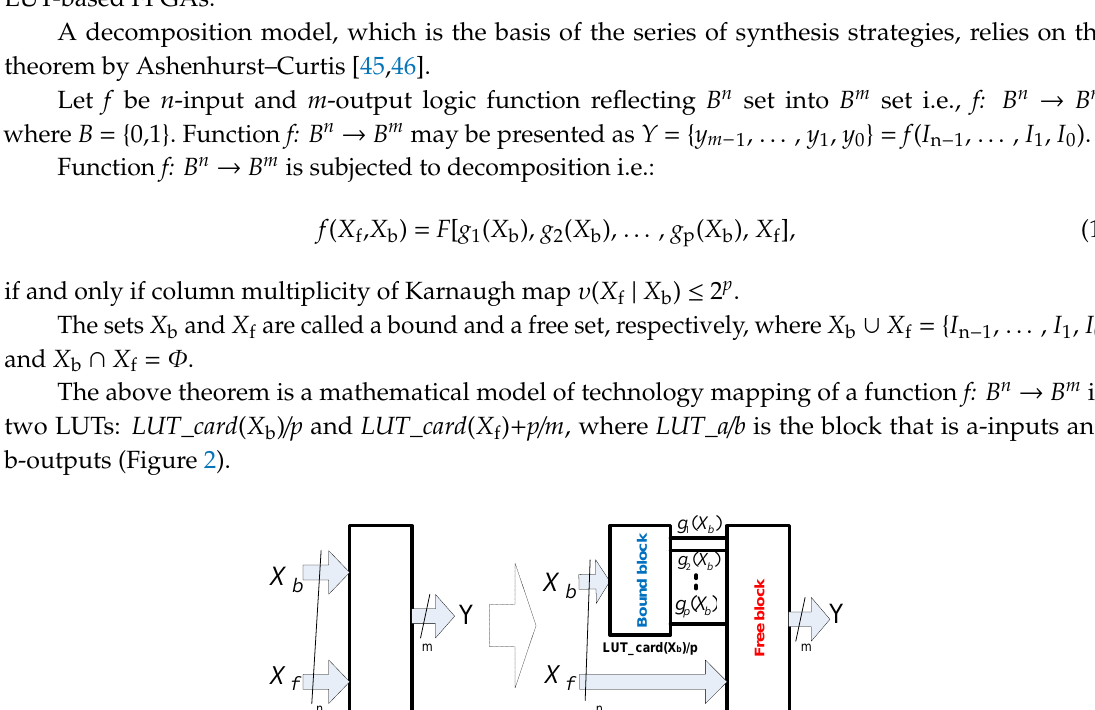
Figure 1. The block scheme of FSM (finite state machine).